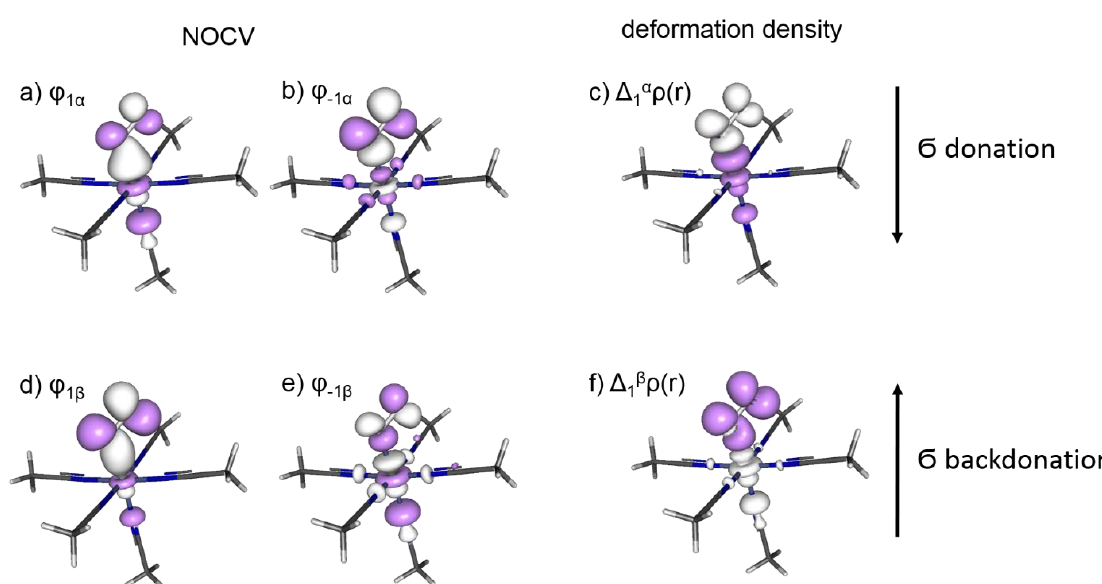
Figure 3. NOCV (pair for α electrons ( a , b ) and for β electrons ( d , e )) and contribution to the deformation density ∆ ρ (r) ( c , f ) originated from the pairs of complementary of NOCVs, characterizing the bond between the Co(CH 3 CN) 52 + fragment and OO ligand. The | ∆ ρ | = 0.05 a.u. contours are shown. White orbitals describe the outflow, and purple describes the inflow of electrons.